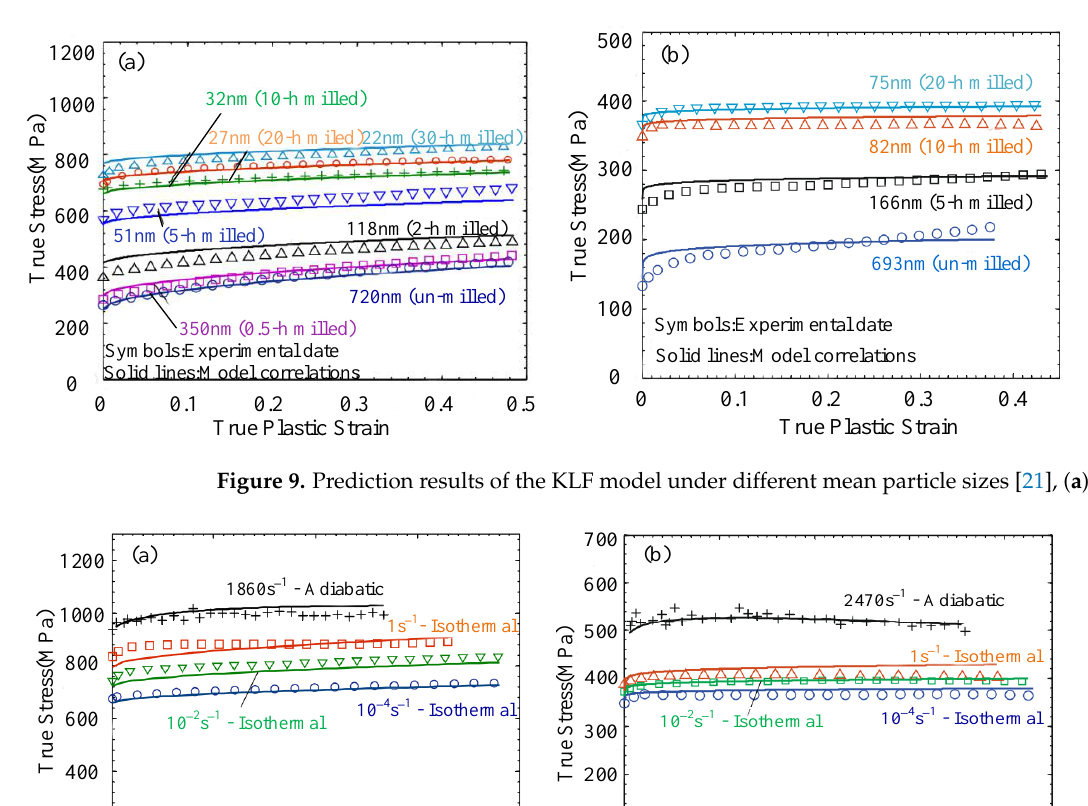
Figure 10. Prediction results of the KLF model under different strain rates [21], ( a ) Cu (d = 32 nm); ( b ) Al (d = 82 nm).